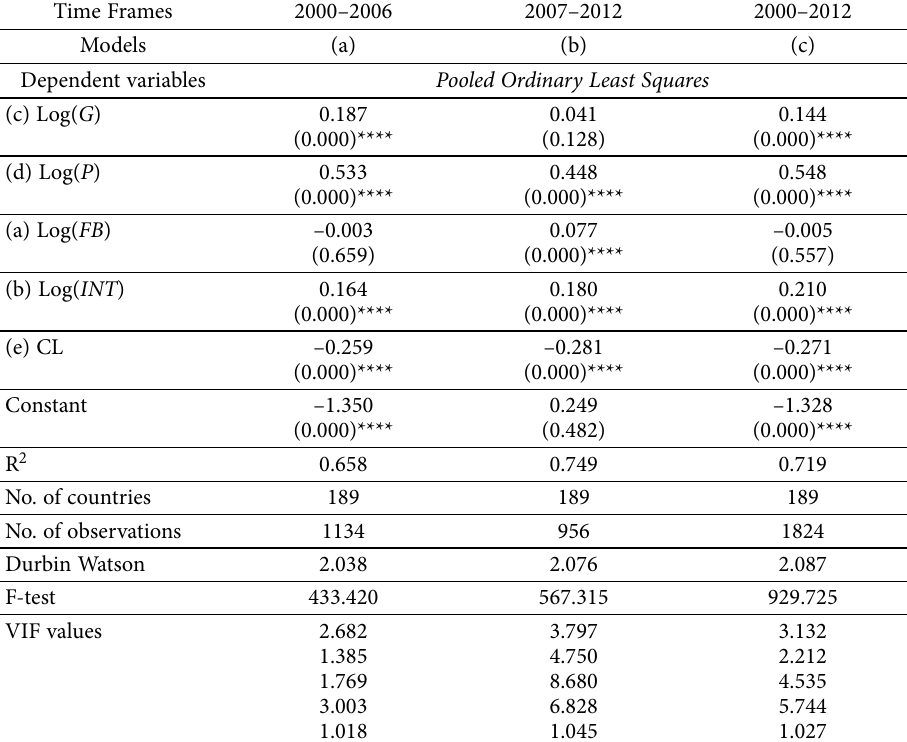
Table 1. Pooled panel OLS gravity